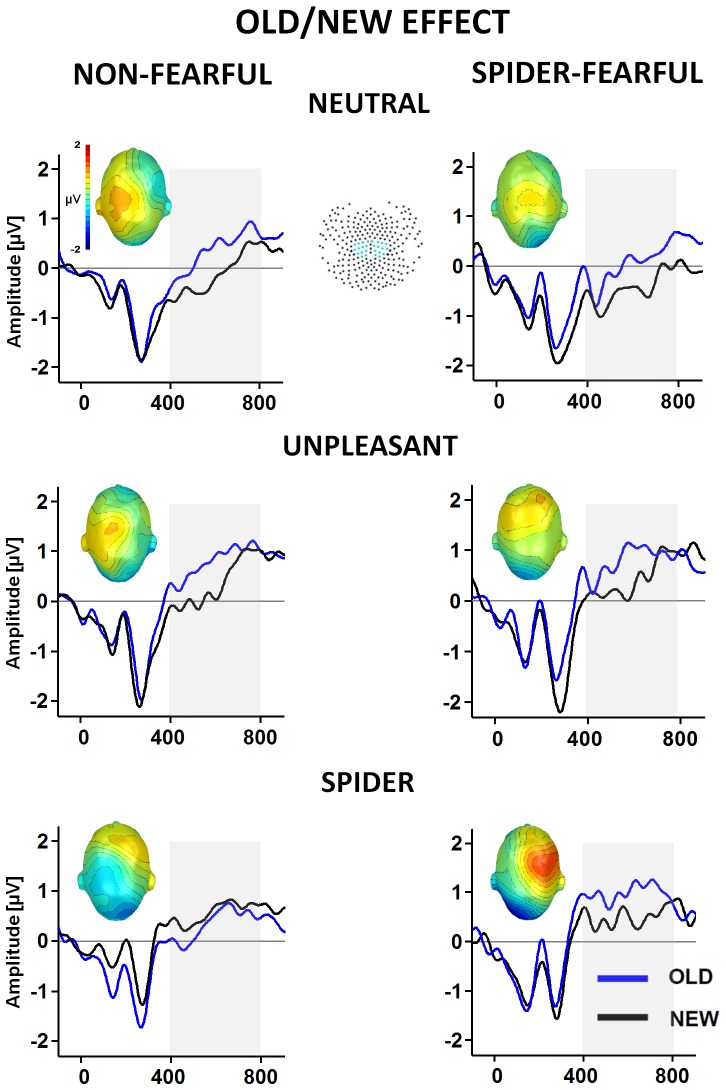
ERP old/new effect in non-fearful and spider-fearful individuals exposed to pictures of naturalistic scenes.The Figure highlights ERP waveforms averaged across centro-parietal channel cluster (see inlet) elicited by correctly classified old and new neutral, unpleasant and spider pictures as well as topographical difference maps (old minus new) displayed for non-fearful control (left) and spider-fearful individuals (right). Shaded areas mark the time interval 400–800 ms selected for the analysis of the ERP old/new effect.